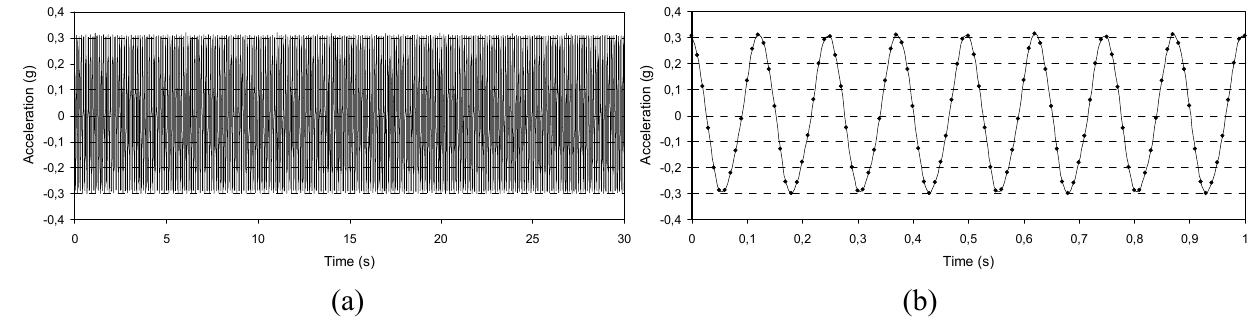
Figure 7. Signal stability before dynamic excitation: 0.3 g amplitude, 8 Hz frequency, x-axis; whole acquisition (a) and detail of the wave form (b).